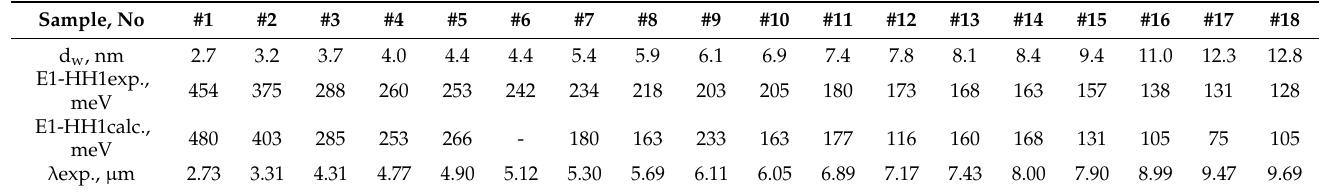
Table 3. Fundamental IBETE E1-HH1 and wavelength values for the proposed